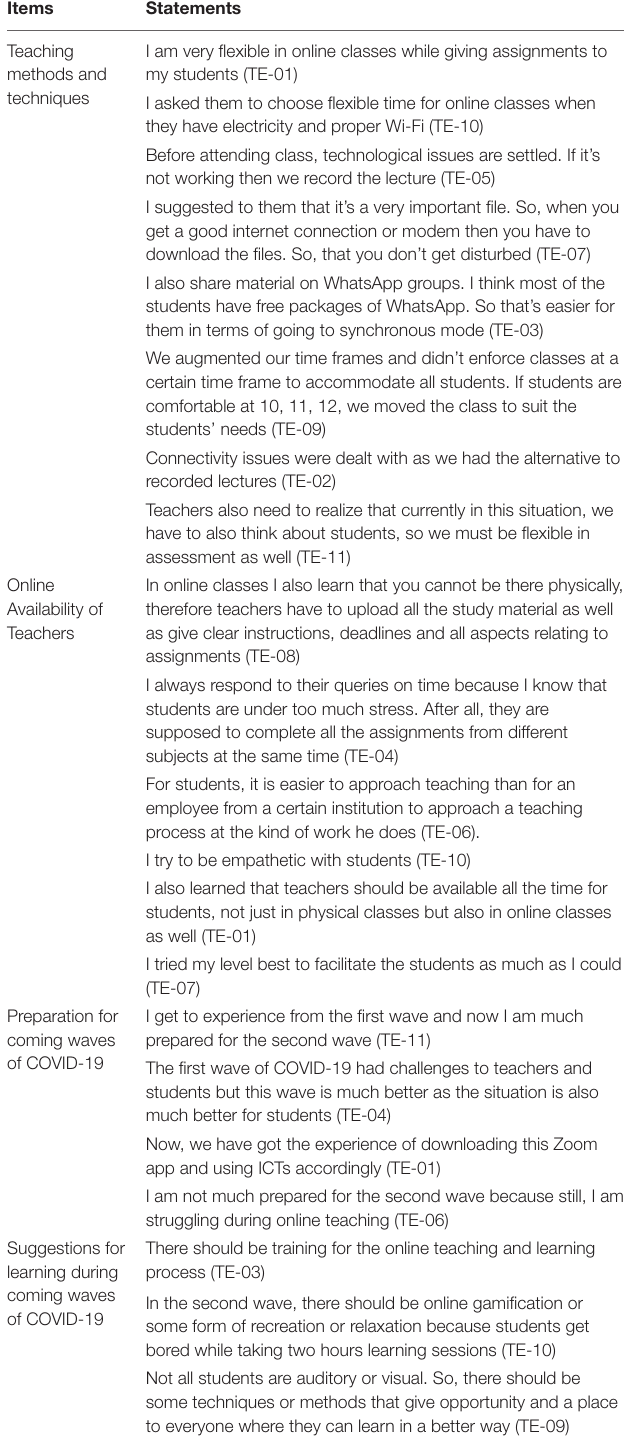
TABLE 5 | Coping strategies to solve the issues and problems of online